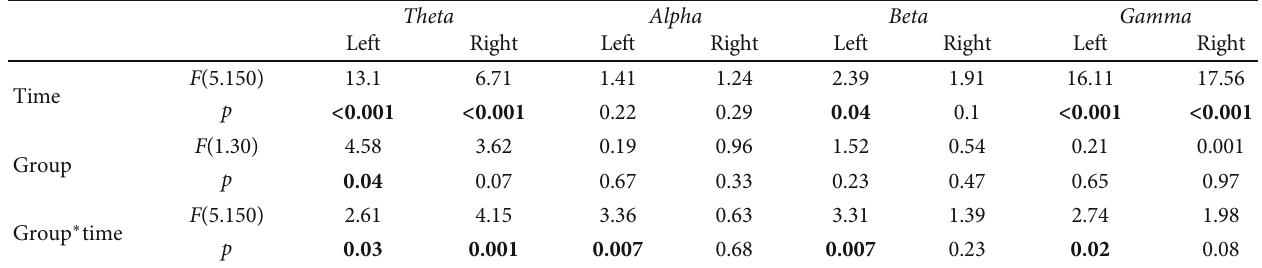
Table 1: Linear mixed model type 3 F -tests to evaluate the e ff ect of time, group, and their interaction for all four frequency bands and both left and right